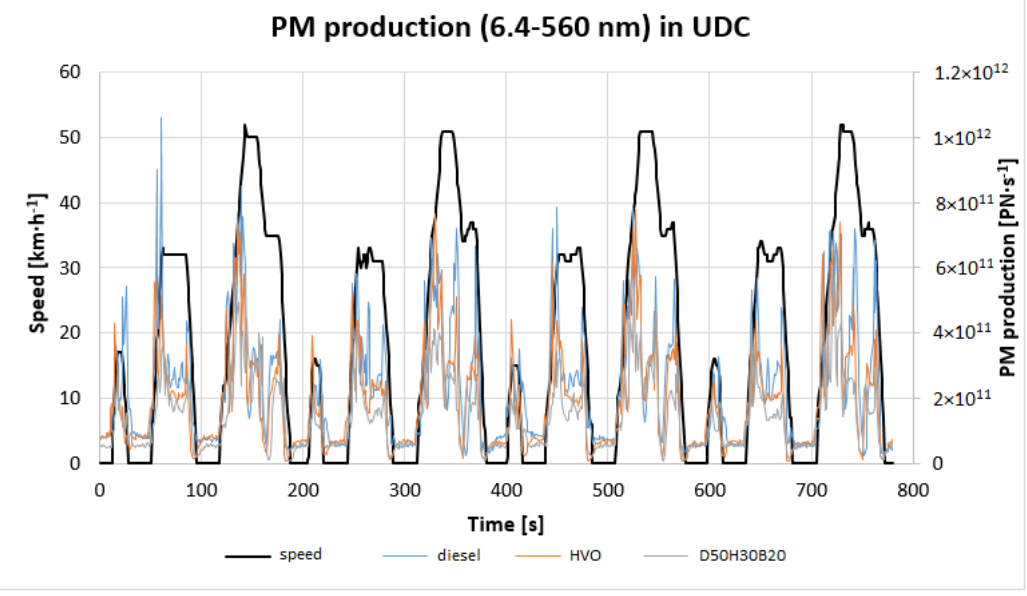
Figure 4. PM production in UDC driving cycle.